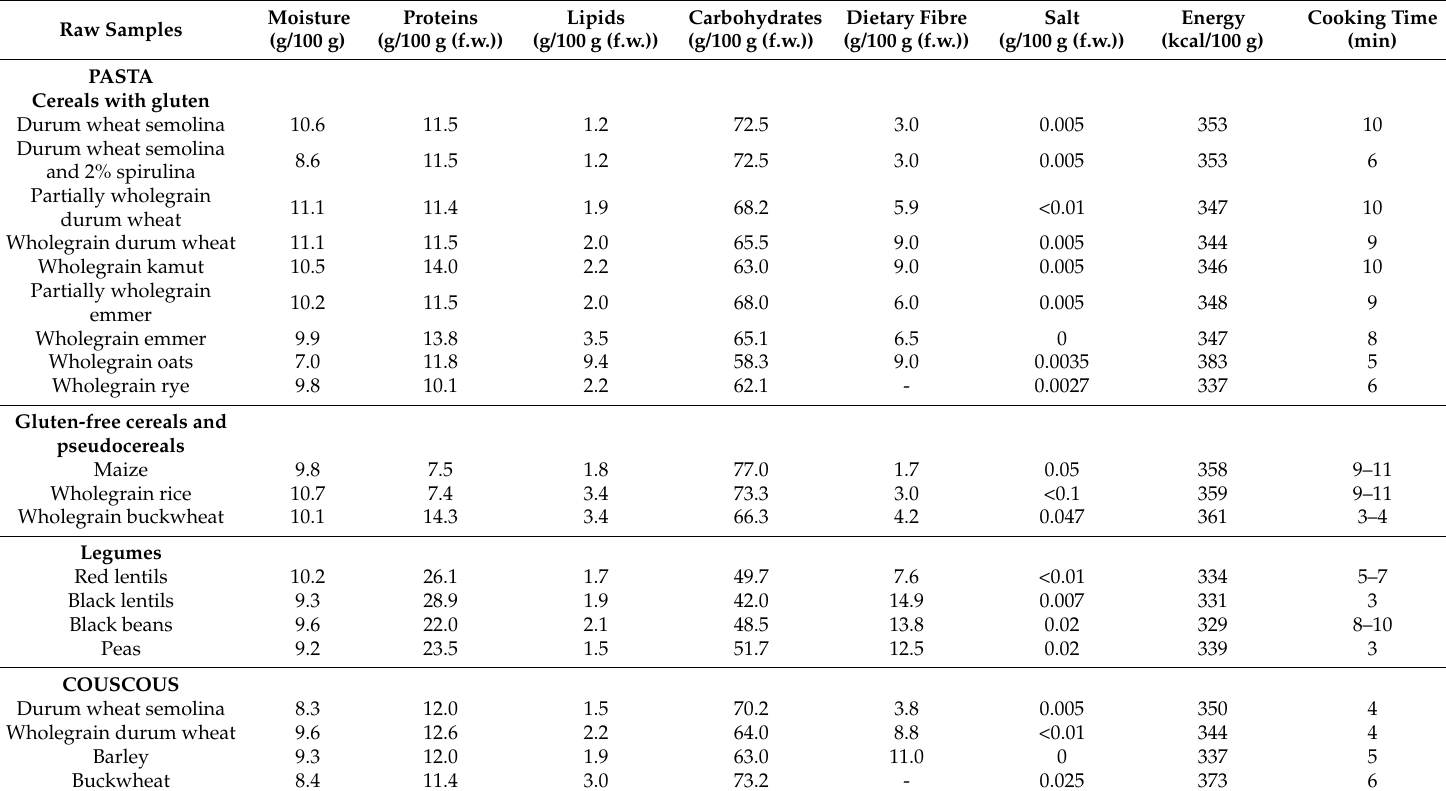
Table 1. Proximate composition, salt, energy and cooking time of commercial samples of short dry pasta and couscous *. Raw